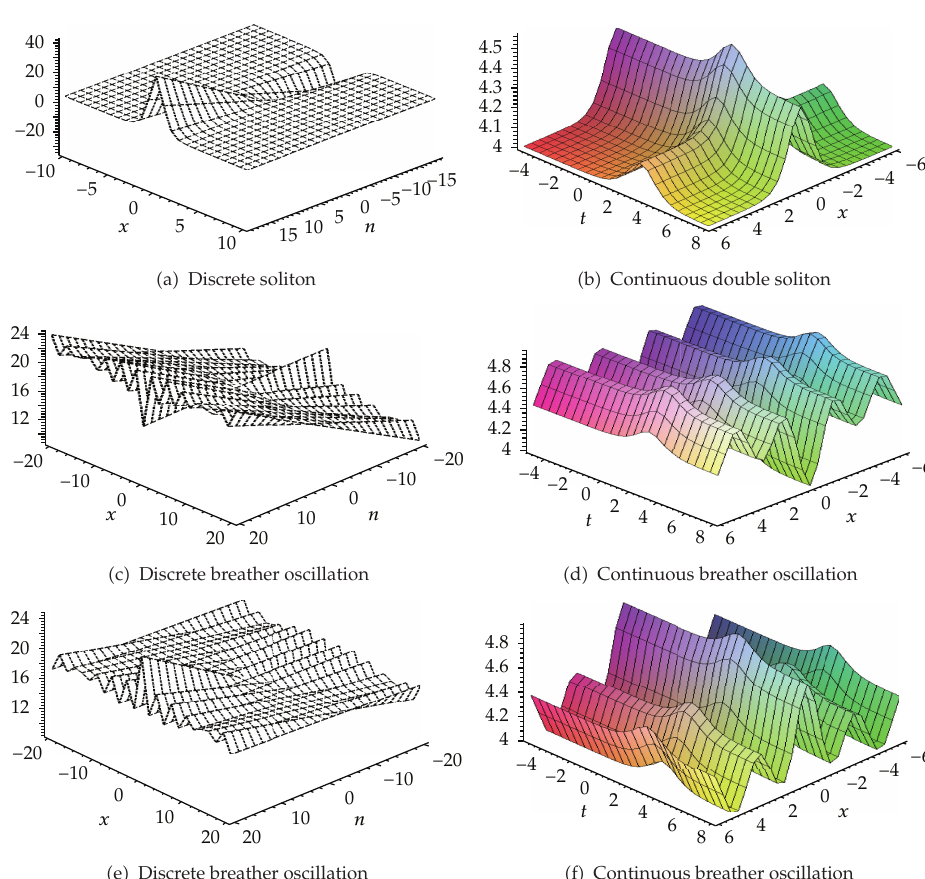
Figure 4: The solutions u n in (cid:2) 3.39 (cid:4) , (cid:2) 3.42 (cid:4) , and (cid:2) 3.43 (cid:4) show six shapes of discrete and continuous solitons and discrete and continuous breather